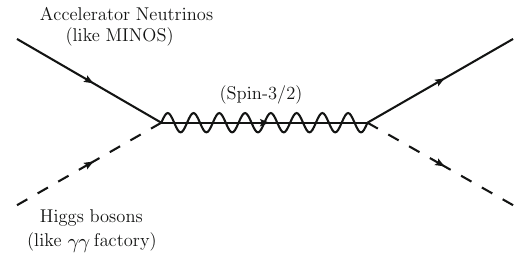
Fig. 5 Possible neutrino–Higgs collider to probe ψ μ